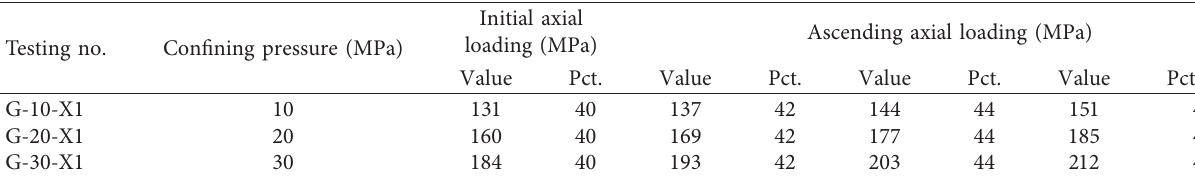
Table 4: Program of ascending step cyclic loading